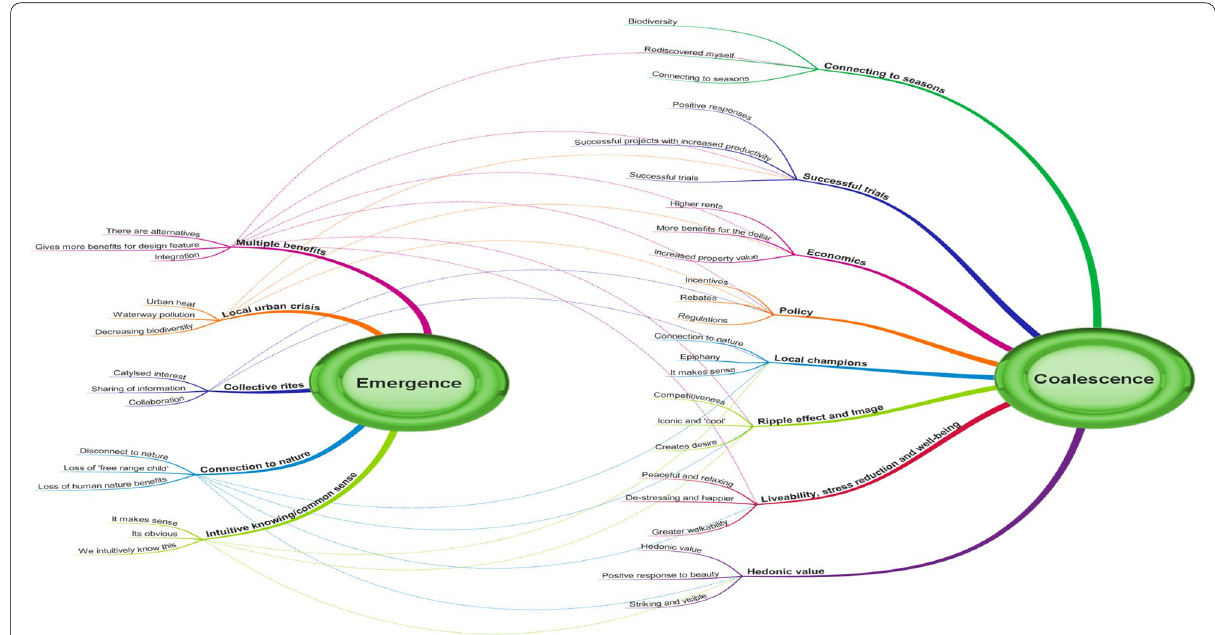
Fig. 1 Composite depiction of the motivating themes in the biophilic design social movement. (Source